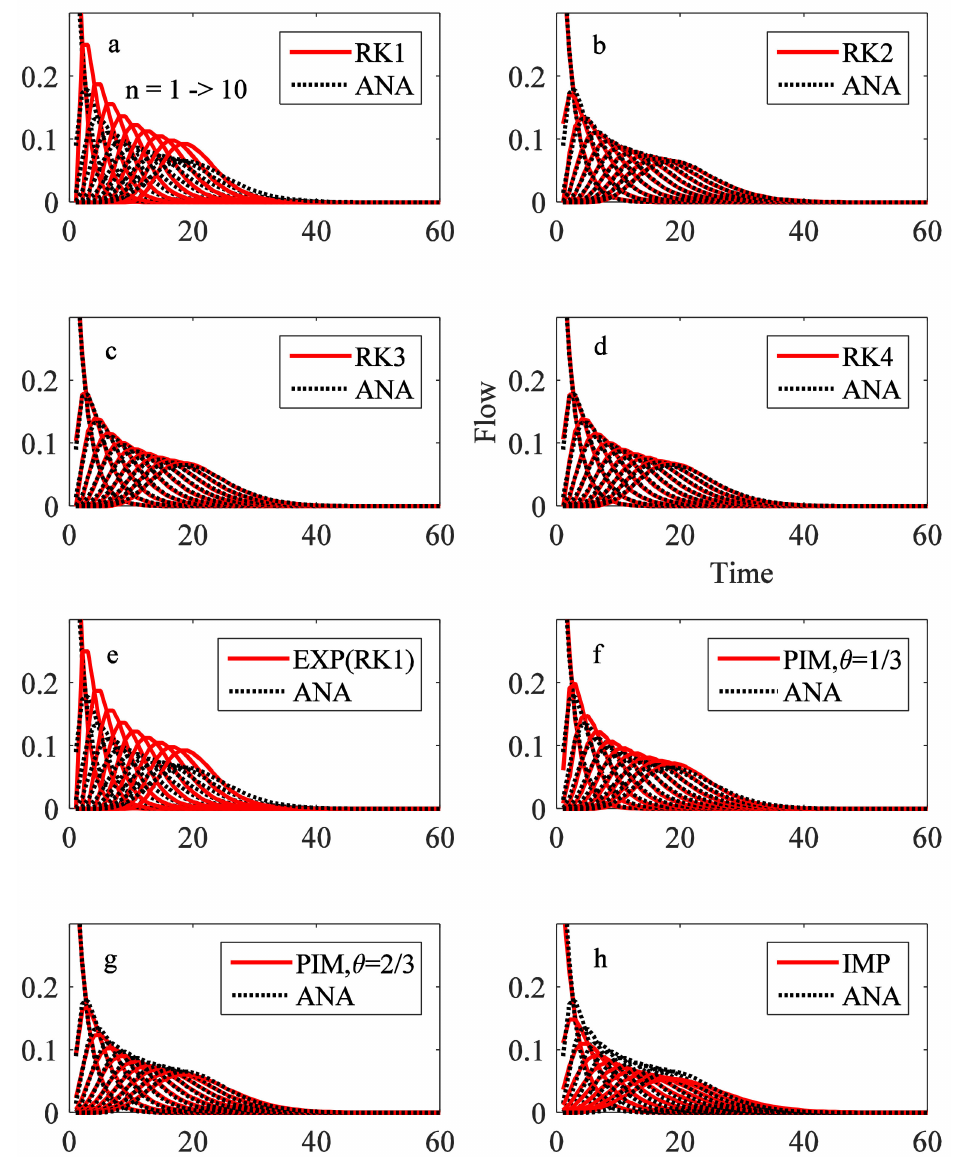
Figure 8. Comparison between the analytical and numerical solutions with: ( a ) 1st order Runge-Kutta scheme (RK1); ( b ) 2nd order Runge-Kutta scheme (RK2); ( c ) 3rd order Runge-Kutta scheme (RK3); ( d ) 4th order Runge-Kutta scheme (RK4); ( e ) explicit Euler scheme (EXP, equivalent to RK1); ( f ) partially implicit Euler scheme (PIM, θ = 1/3); ( g ) partially implicit Euler scheme (PIM, θ = 2/3); and ( h ) implicit Euler scheme (IMP, θ = 1). ANA represents the analytical solution, θ represents the implicit factor and n is the number of linear reservoirs in the Nash cascade process. Curves from left to right in each plot correspond to n increasing from one to